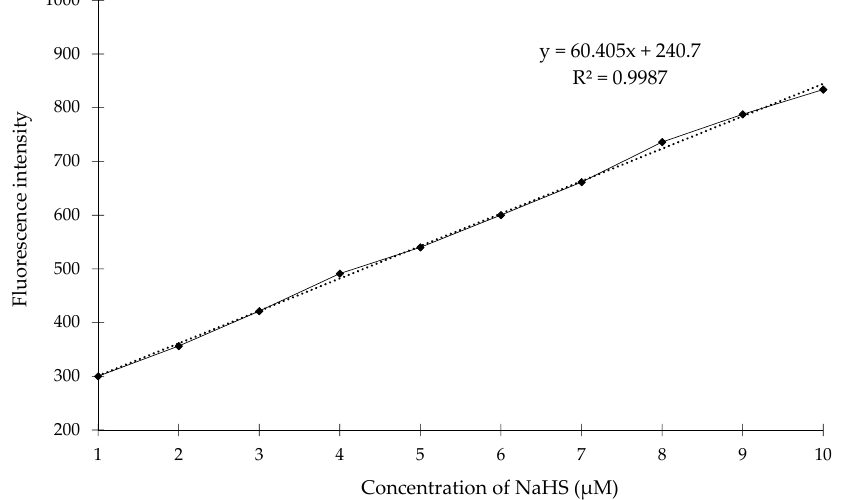
Figure 13. The correlation between fluorescence intensity and NaHS concentration determined using a fluorometer: the compound 1 (0.1 mM) with NaHS (1–10 μ M) in sodium phosphate buffer ( λ ex = 365 nm) at room temperature. The points represent the mean fluorescence responses at 10 min after the addition of